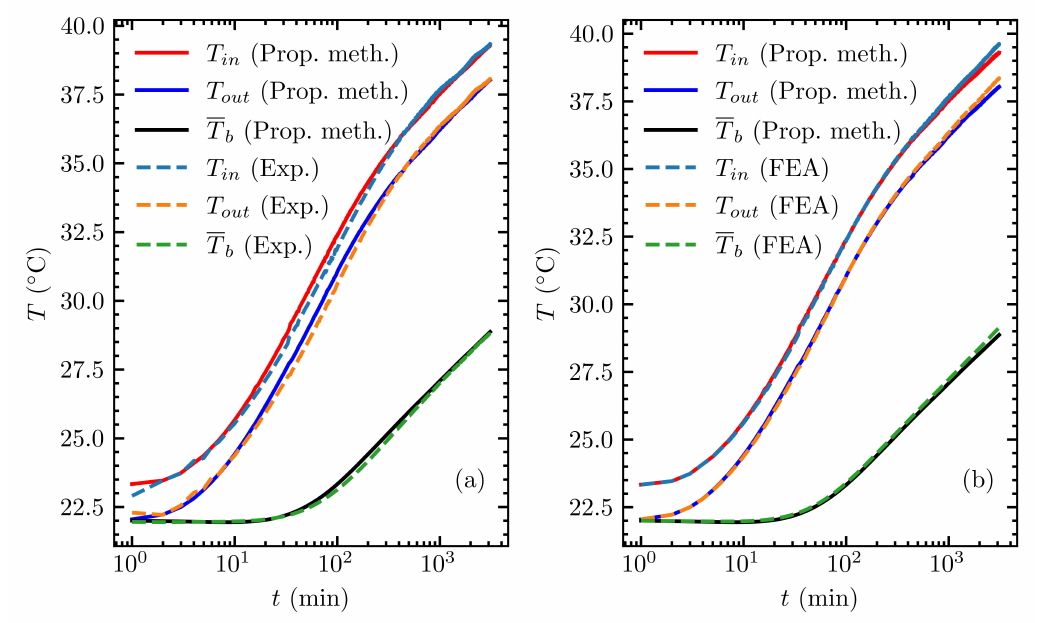
Figure 6. Comparison of the proposed model with ( a ) the experimental data of Beier et al. [37] and ( b ) the FEA